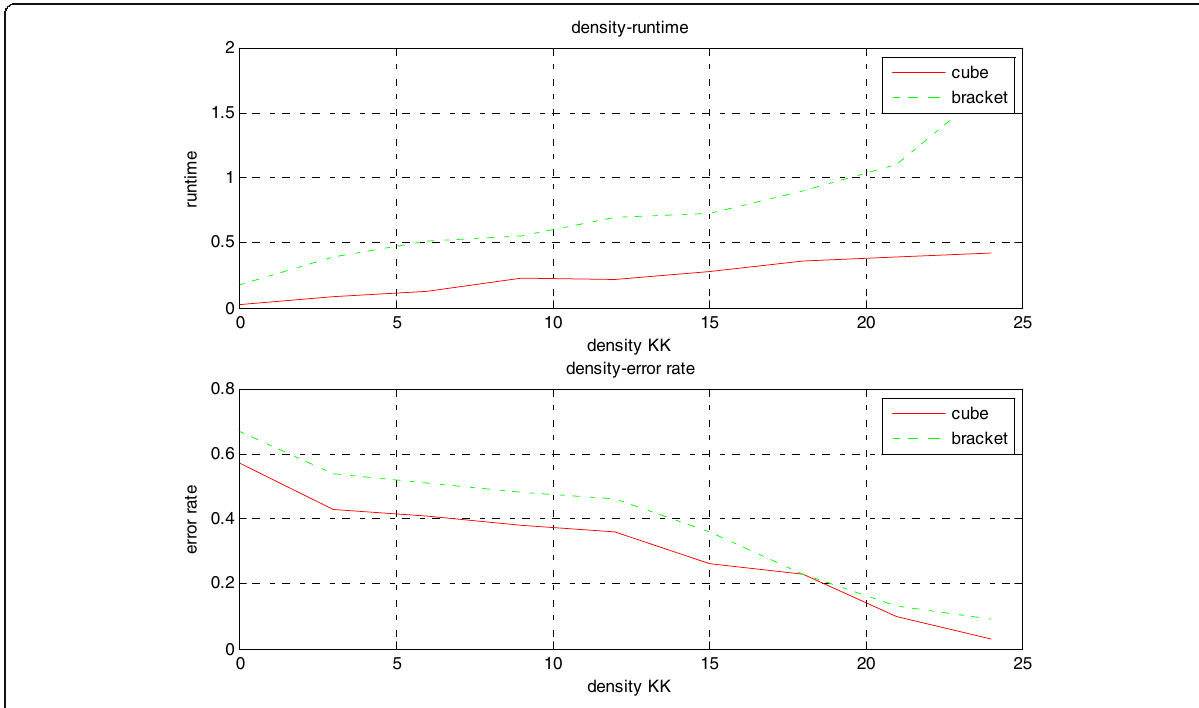
Fig. 8 Accuracy and runtime as to the aspect density